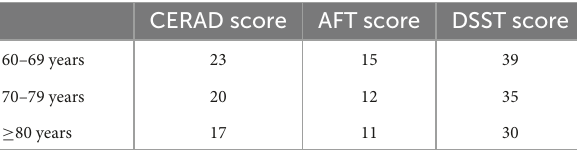
TABLE 1 The cognition performance cut-off points of test score, adjusted according to